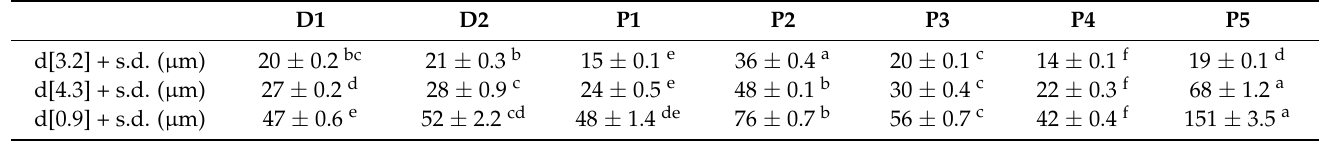
Figure 1. The final carbohydrate, sugar, and protein content as labelled in the products (w-%) and ◦ Brix (%) with standard deviation. Superscript letters indicate statistical difference in ◦ Brix (%) between the samples ( p < 0.05). Table 4. Particle size diameters ( ± standard deviation) of all the samples. Superscript letters indicate statistical difference in the same row ( p < 0.05).